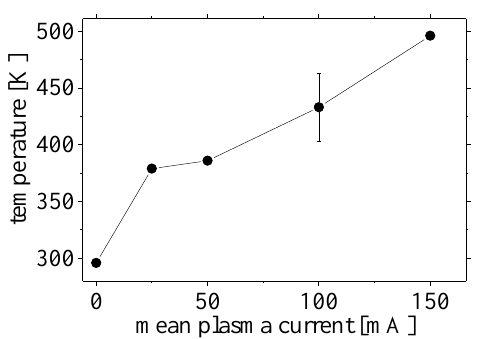
Figure 4. Calculated gas temperatures during the plasma pulse as a function of the mean plasma current. The total pressure of the gas mixture containing 0.8 % NO in air was 1.33 mbar [50], © IOP Publishing. Reproduced with permission. All rights reserved.